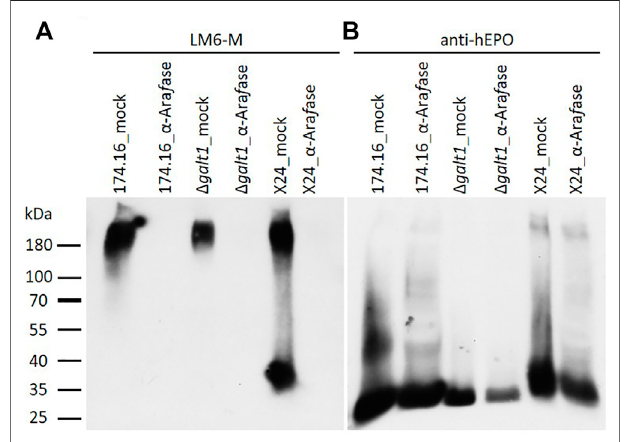
FIGURE 3 | Western blots of mock-treated and α -L- arabinofuranosidase-digested samples from rhEPO-producing Physcomitrella lines. Ten microgram total protein of precipitated culture supernatantsoftherhEPO-producinglines174.16, Δ galt1 andX24were digested with one unit of α -L-arabinofuranosidase ( α -Ara f ase), while control samples were treated equivalently but without α -L-arabinofuranosidase (mock). After separation on SDS-PAGE and blotting, the PVDF-membrane wassubsequentlyincubatedwiththeanti-1,5- α -L-arabinanantibody(LM6-M, 1:10) (A) and an anti-hEPO monoclonal antibody (1:4,000) (B) .